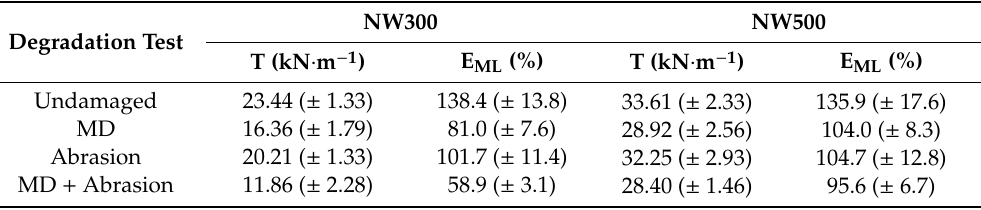
Table 3. Tensile properties of the nonwoven geotextiles NW300 and